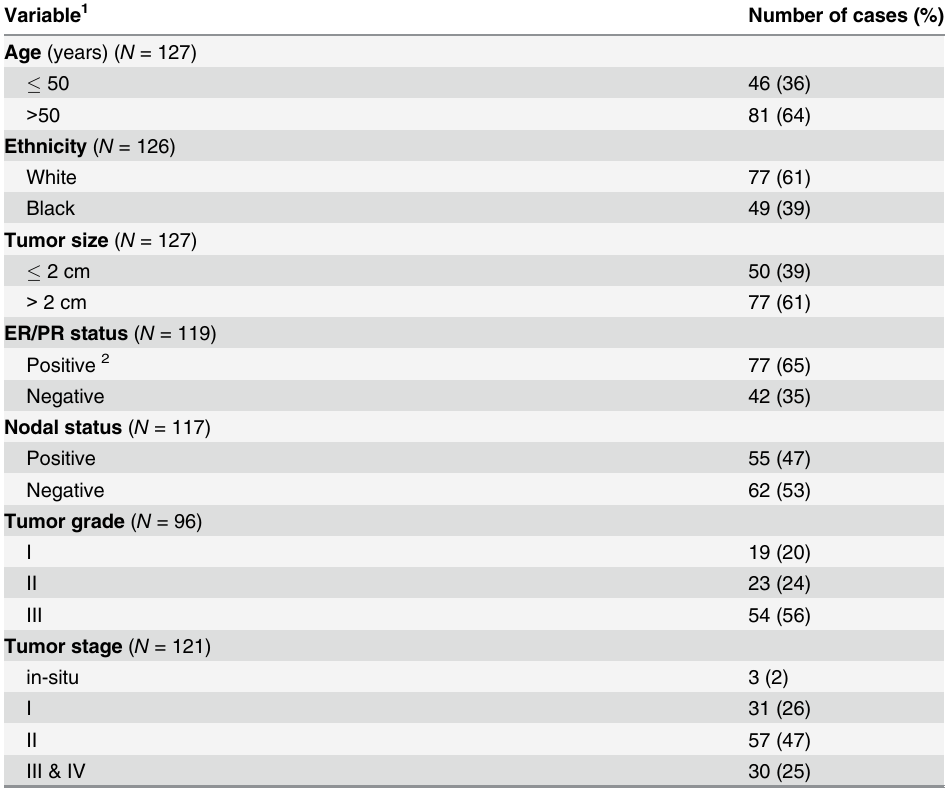
Table 1. Characteristics of the study